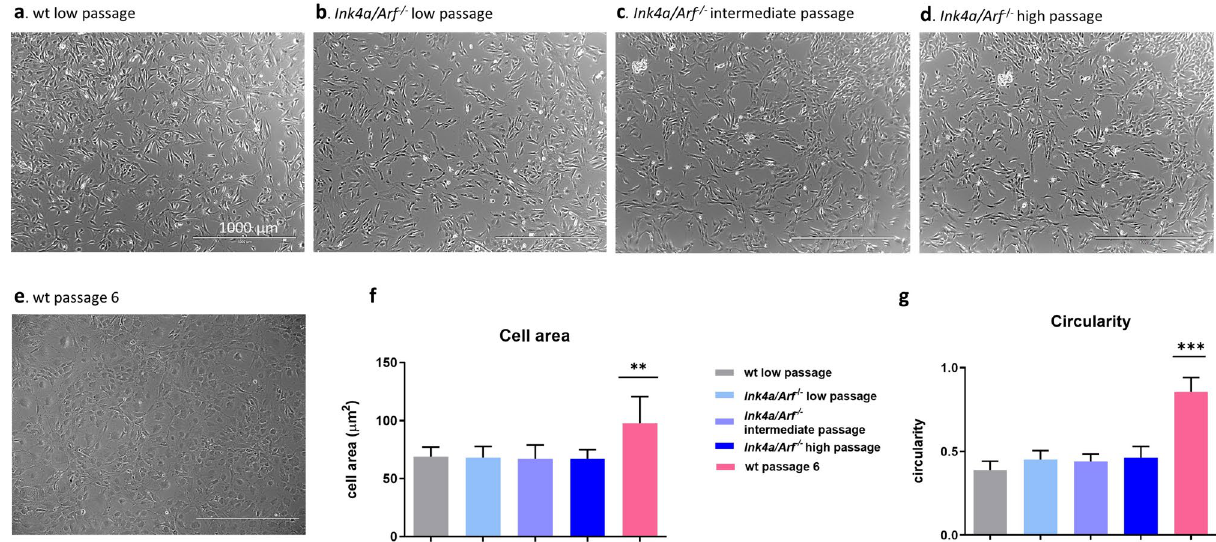
Figure 2. Morphology, cell area and circularity of Ink4a/Arf − / − cells in comparison to wild-type (wt) cells in different passages. ** p -value < 0.01, *** p -value < 0.001. a – e wt tenocytes in a low passage ( a , passage 2–5) and Ink4a/Arf − / − tenocytes in a low ( b , passage 2–5), intermediate ( c , passage 14–17) and high ( d , passage 35–44) passage showed similar tenogenic morphology while in wt tenocytes in passage 6 ( e ) phenotypic drift was already apparent. Micrographs were obtained using phase contrast with a 40 × objective (scale bar = 1000 µm). ( f ) Cell area (μm 2 ) of the wt cells and the Ink4a/Arf − / − cells in different passages. Wt cells in passage 6 showed significantly higher cell area indicative for dedifferentiation. ( g ): Circularity (0–1 range) of the wt cells and the Ink4a/Arf − / − cells in different passages. Circularity in wt cells in passage 6 was significantly closer to 1 than the rest of the groups suggesting a rounder appearance indicative for dedifferentiation.